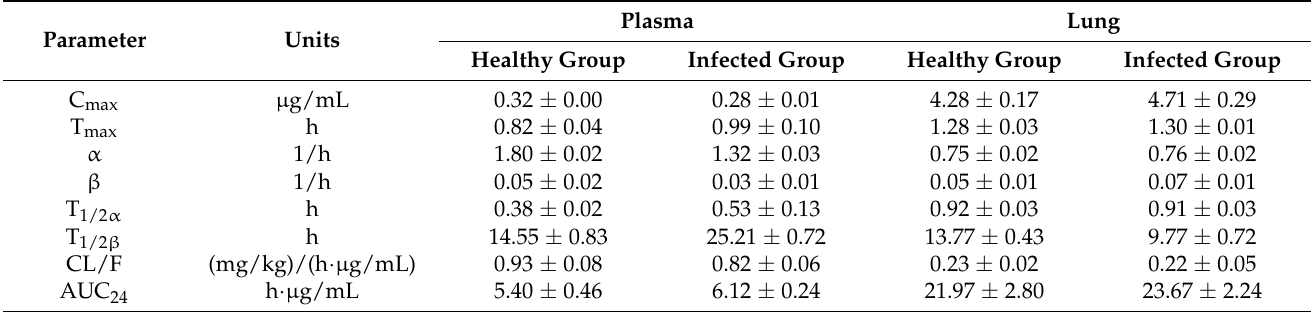
Table 2. PK parameters in plasma (left) and lung (right) in healthy ( n = 65) and infected ( n = 65) broilers after an oral administration of danofloxacin at a dose of 5